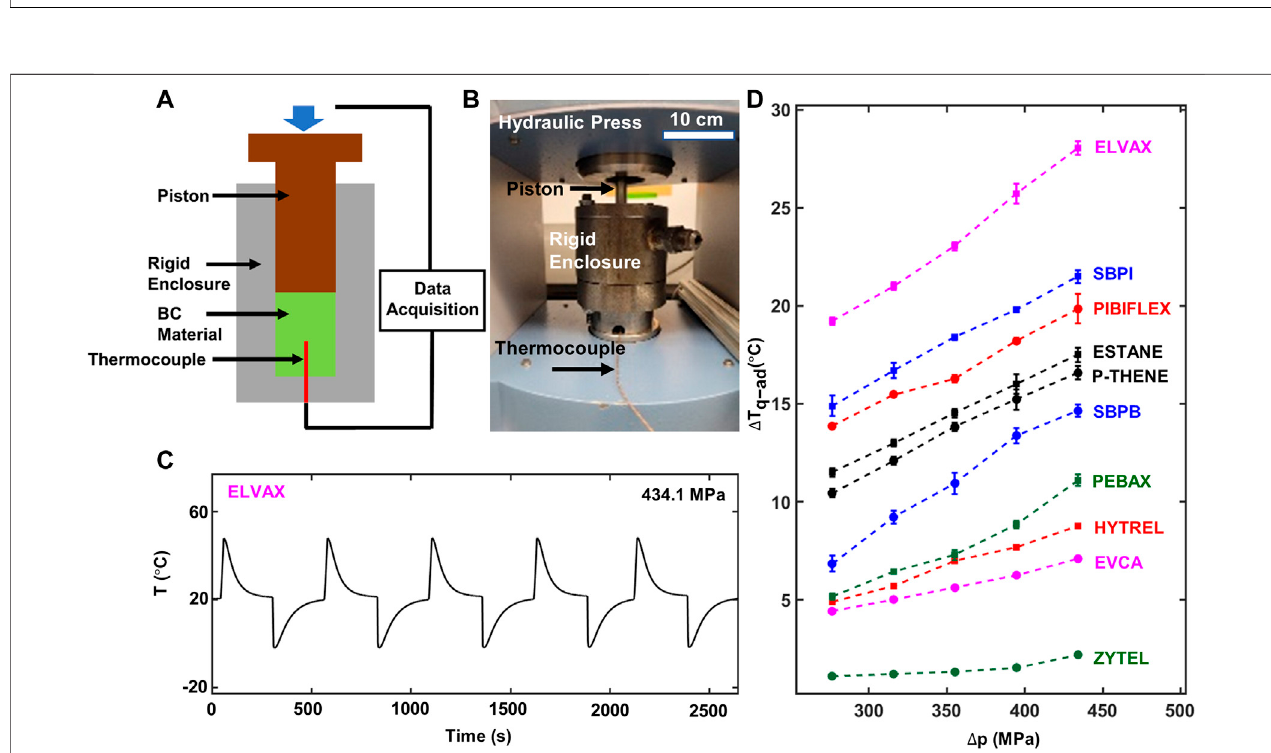
FIGURE 6 | Direct barocaloric temperature change measurement. (A) Schematic representation and (B) photograph of the custom-fabricated setup for the direct measurementofthepressure-inducedtemperaturechange. (C) Measuredtemperatureofarepresentativematerial(ELVAX)subjectedto fi vepressure( Δ p =434.1 MPa) applications and release cycles. (D) Measured temperature rise as a function of applied pressure ( Δ p ) for the materials tested around room temperature.